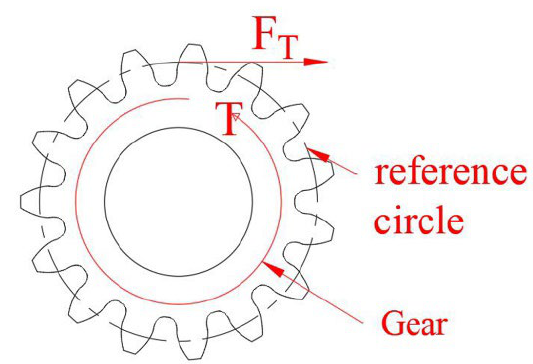
Figure 4. Relationship between F T and T .